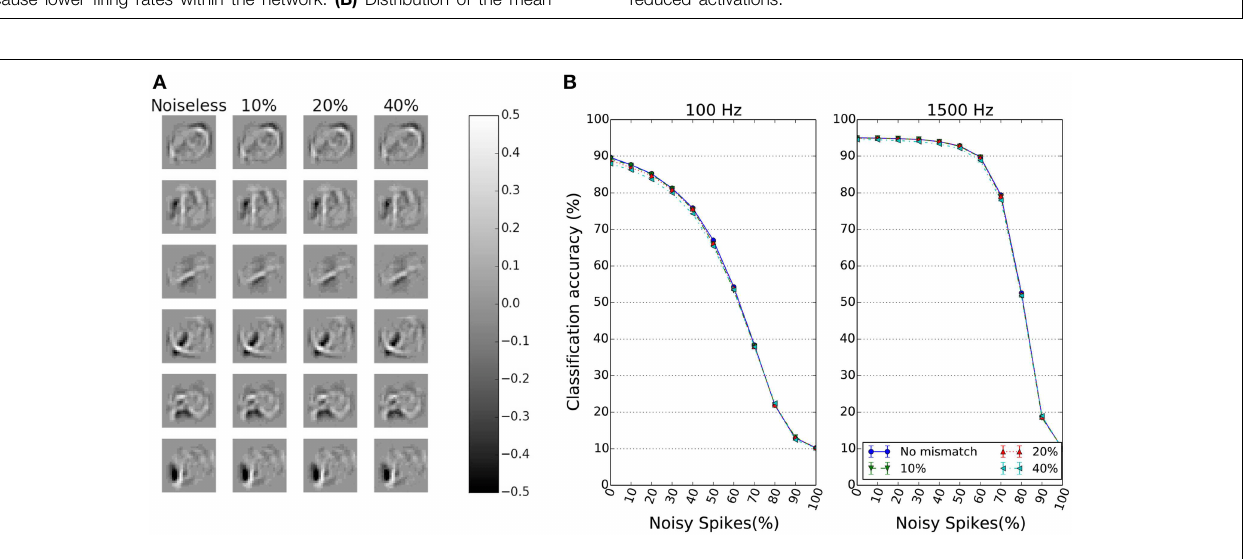
difference between the activation of a neuron with double precision weights and neurons using weights with different bit precision levels. Shown are distributions over all test samples. The difference, although peaked near zero, increases for higher layers, and shows a trend toward reduced activations.